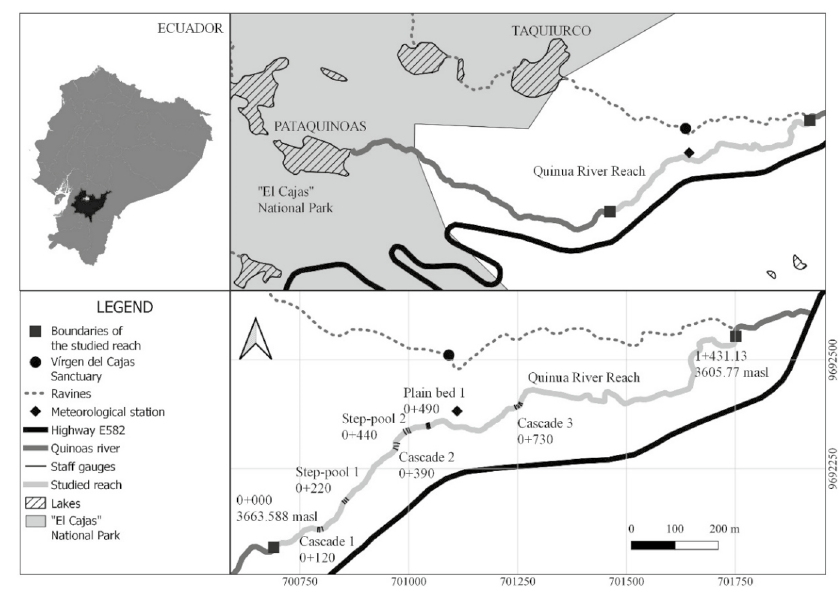
Fig. 2 Plan view of the studied 1500 km river reach showing the sequence of the sub‑reaches and the location of the meteorological